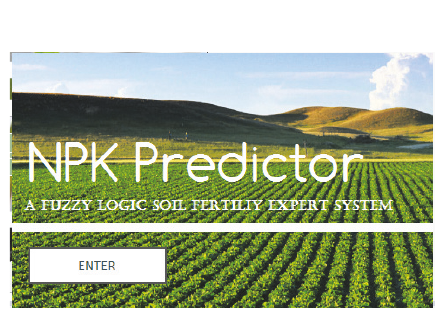
Figure 3: Front page.